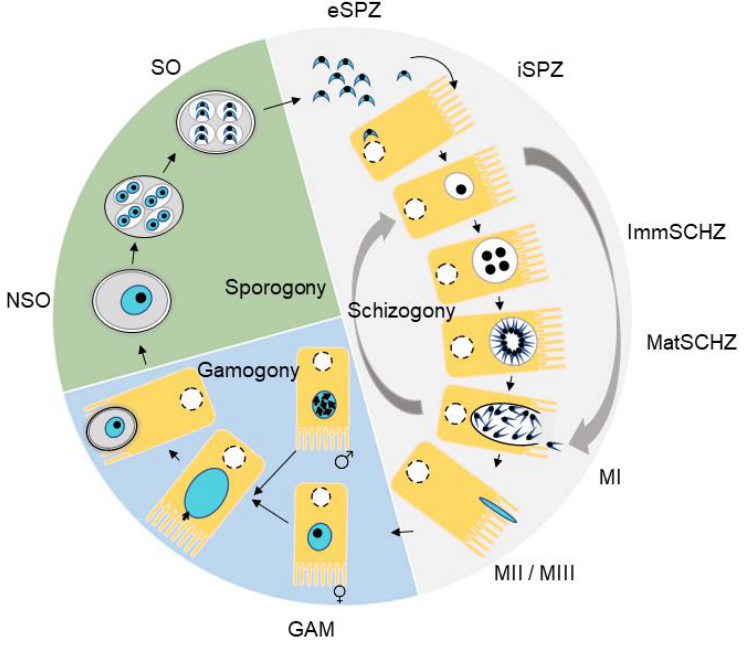
Figure 1. Eimeria tenella life-cycle. Sporogony occurs in the environment, whereas schizogony and gamogony occur in the chicken digestive tract. For the wild-type strain, three rounds of schizogony produce first-, second-, and third-generation merozoites. NSO, non-sporulated oocysts, SO sporulated oocysts, eSPZ extracellular sporozoites, iSPZ intracellular sporozoites, ImmSCHZ immature schizonts, MatSCHZ mature schizonts, MI first-generation merozoites, MII second-generation merozoites, and MIII third-generation merozoites.